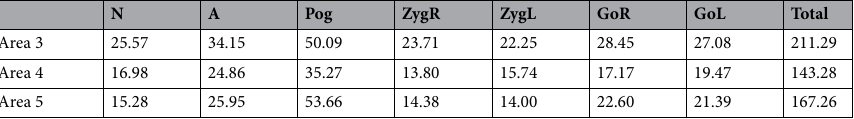
Table 2. Sum of differences (mm) of each surface superimposition outcome from the ACB voxel-based superimposition outcome in each of the seven areas measured (n = 18).